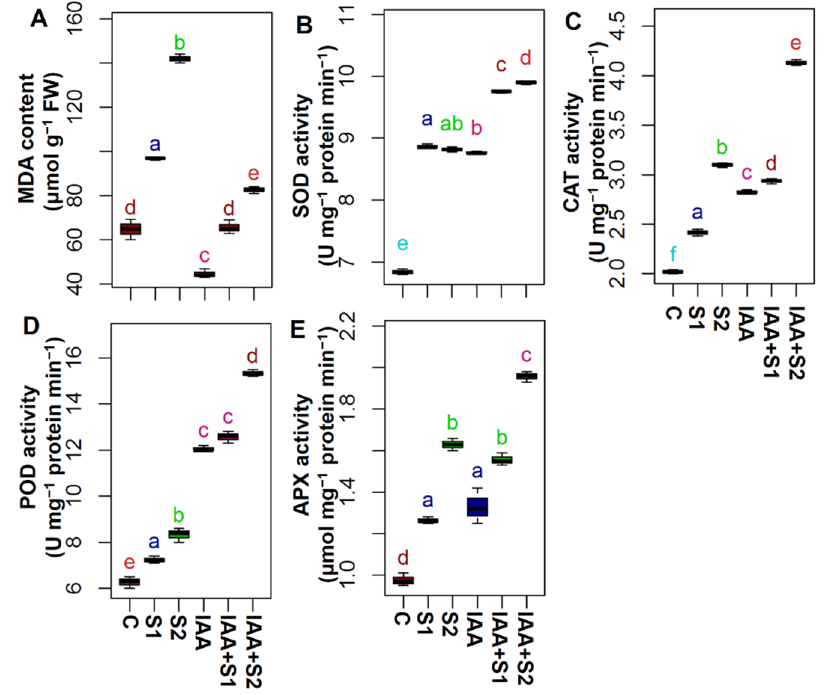
Figure 5. Effects of exogenous IAA on ( A ) malondialdehyde (MDA) content and activities of ( B ) superoxide dismutase (SOD), ( C ) catalase (CAT), ( D ) peroxidase (POD), ( E ) ascorbate peroxidase (APX) of V. faba plants grown under non-stress and saline conditions. Each boxplot represents values of three independent replicates ( n = 3). Different letters above the bars indicate a statistically significant difference ( p < 0.05) by Tukey’s test. C, (control) 0 mM NaCl + water spray; S1, 60 mM NaCl + water spray; S2, 150 mM NaCl + water spray; IAA, 0 mM NaCl + 200 ppm IAA; IAA + S1, 60 mM NaCl + 200 ppm IAA; IAA + S2, 150 mM NaCl + 200 ppm IAA.